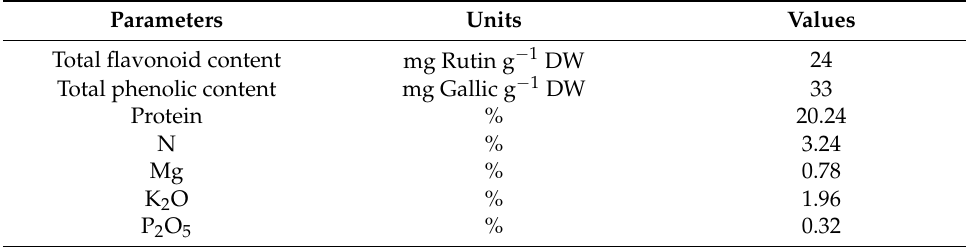
Table 11. Azolla filiculoides Lam. plant extract chemical characteristics.